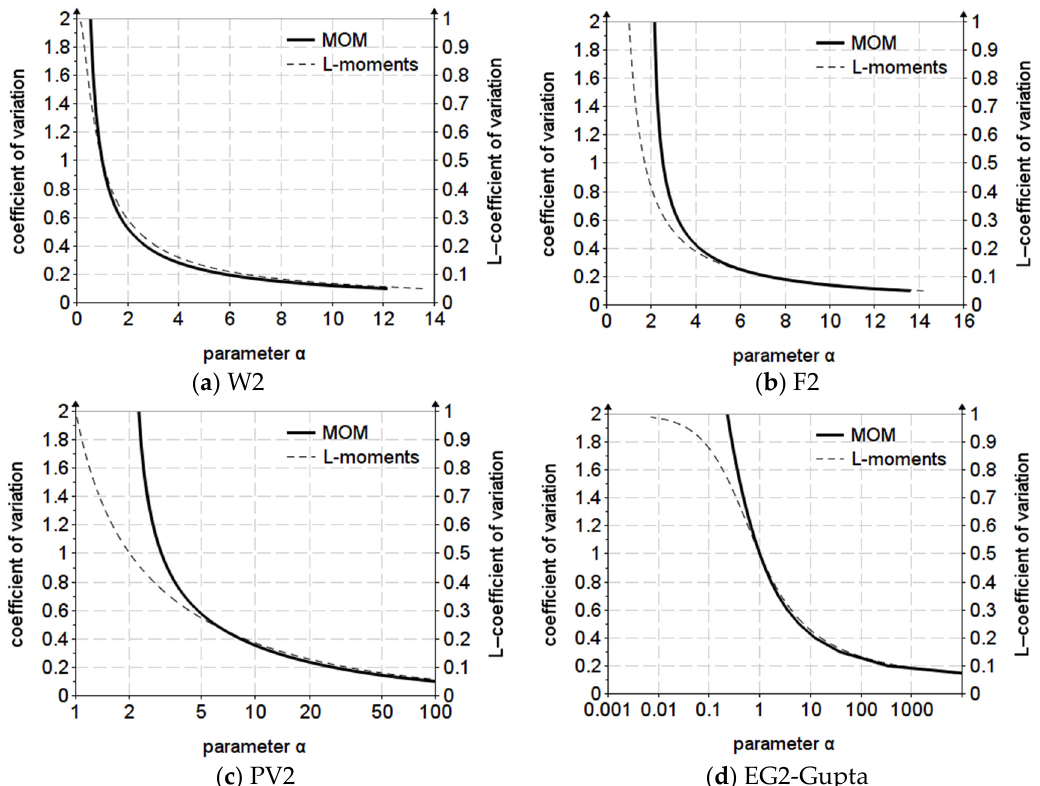
C v 0 1 . The func- 2 C ) and L- v